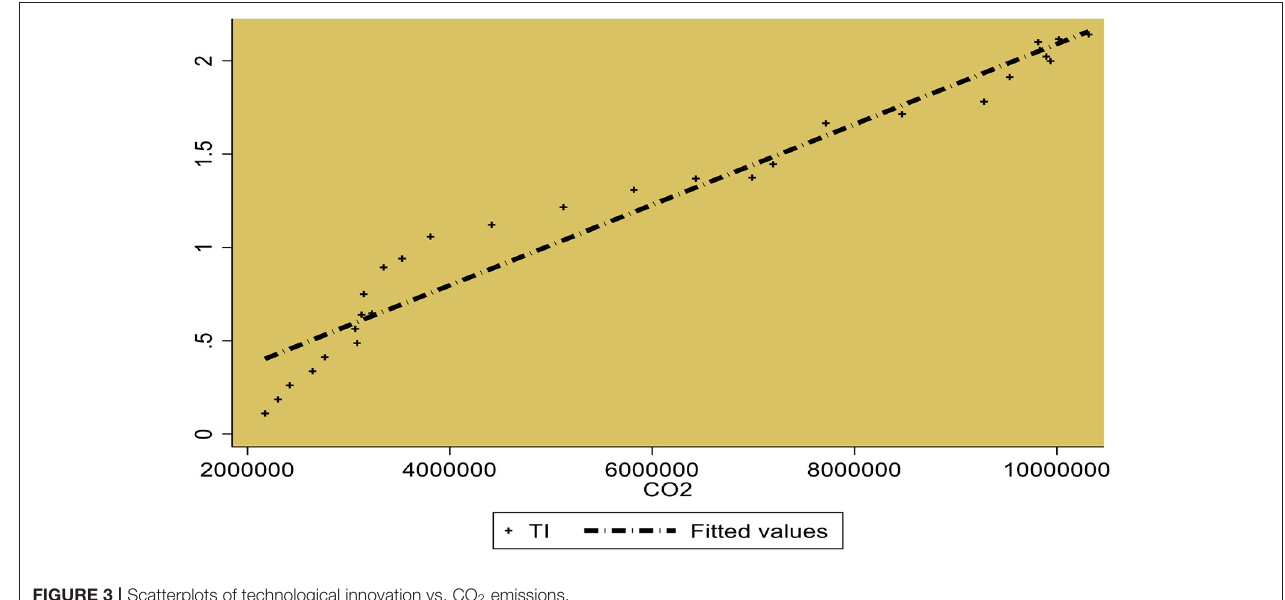
FIGURE 3 | Scatterplots of technological innovation vs. CO 2 emissions.